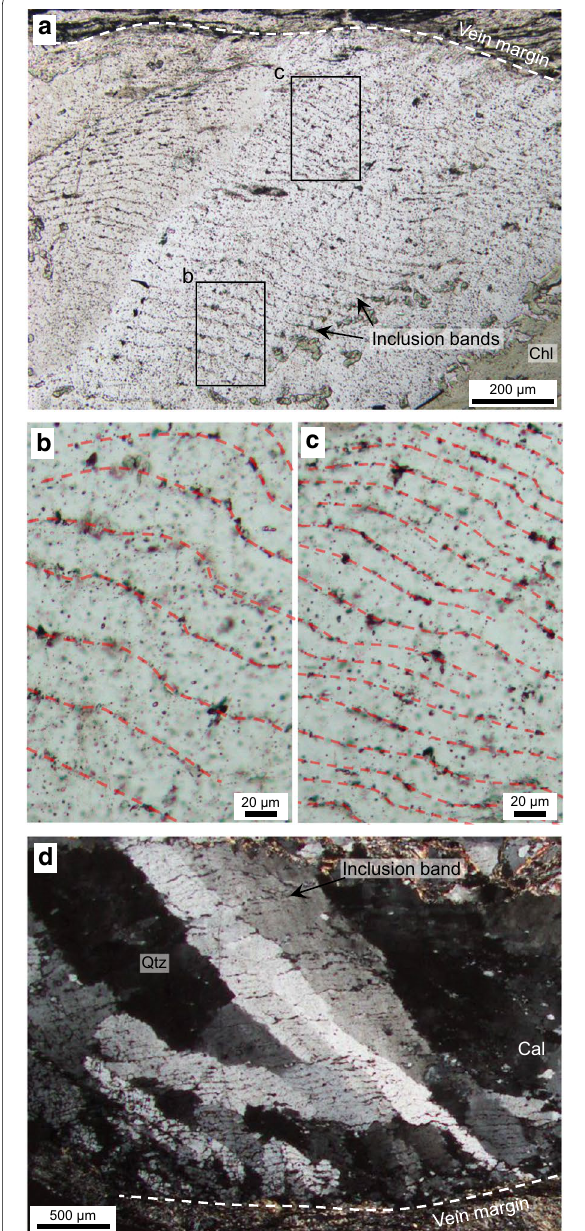
Fig. 2 a Micrograph (plane-polarized light) of phyllosilicate inclusion bands (transect 3 in sample R2) showing upward decrease in band spacing. b , c Closeup of inclusion bands. Locations of the images are shown in ( a ). Dashed red lines indicate inclusion bands. d Micrograph (cross-polarized light) of shear vein, showing an elongate-blocky quartz crystals. All micrographs were taken from the thin sections cut parallel to slickenfiber lineations and perpendicular to vein margin. Qtz quartz, Chl = =